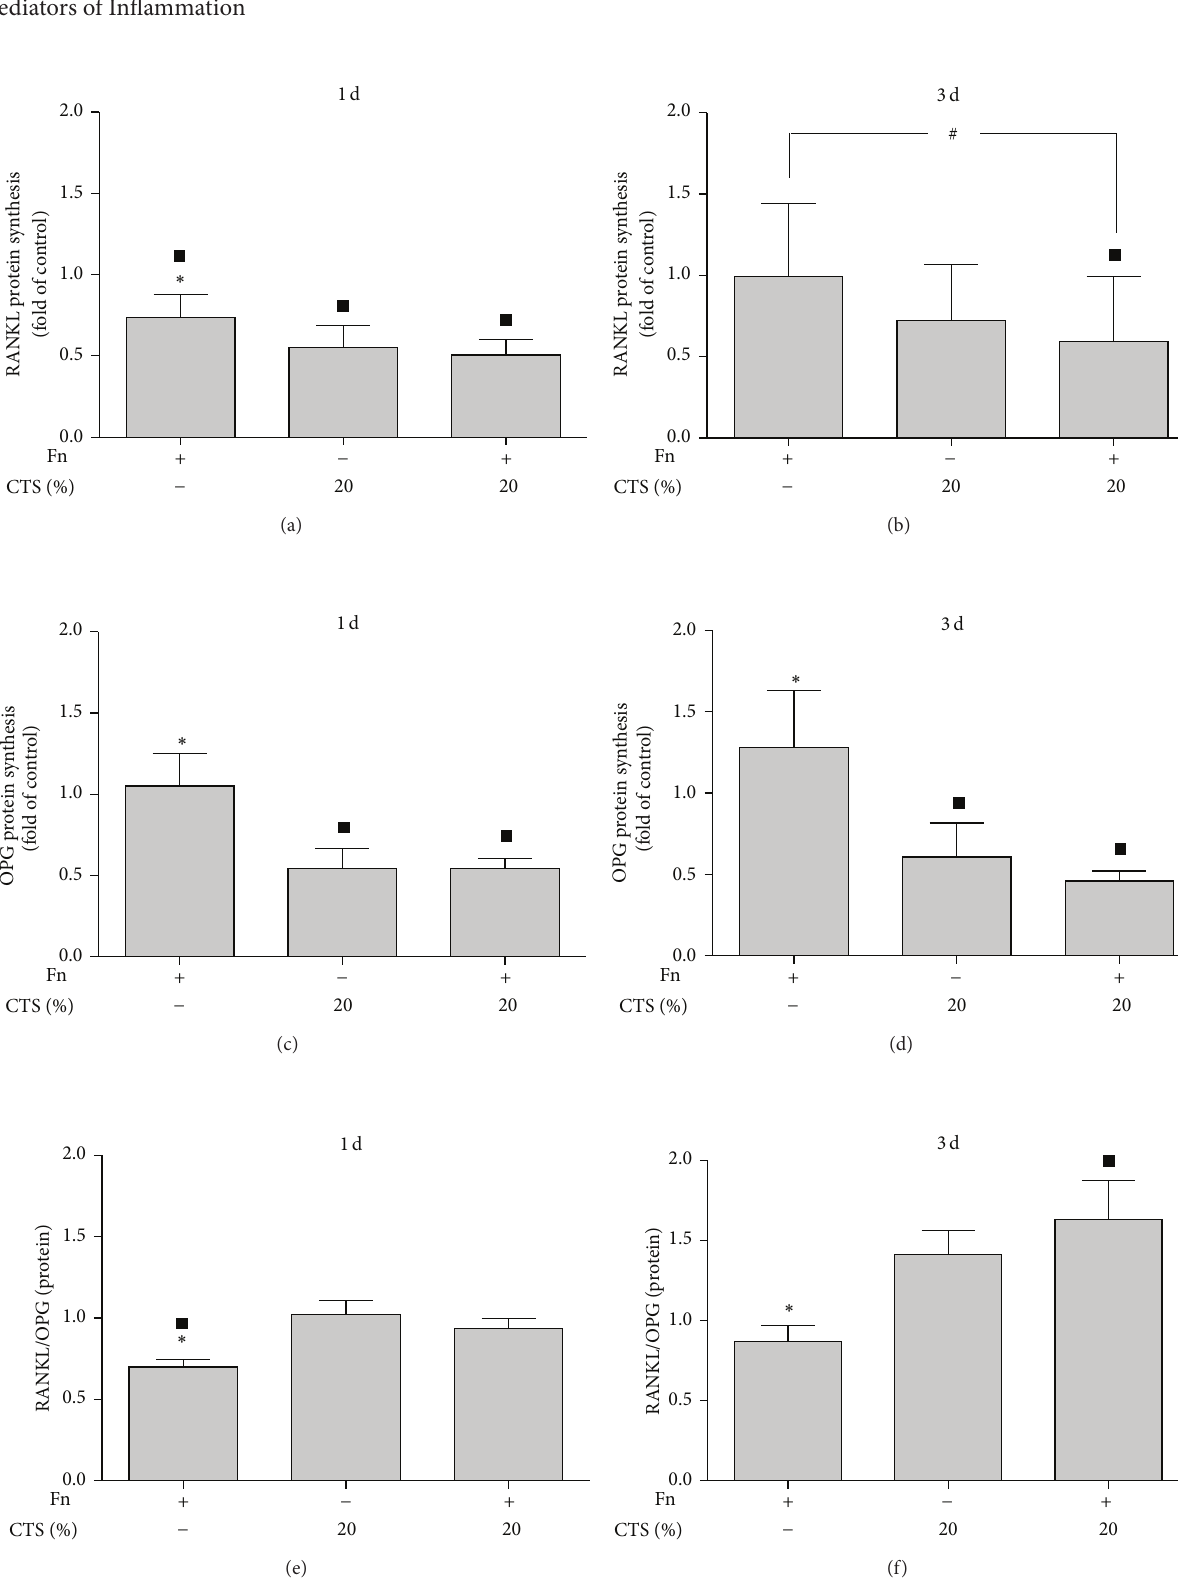
Figure 4: (a and b) Synthesis of RANKL protein in supernatants of PDL cells stimulated by F. nucleatum ATCC 25586 and/or CTSH at 1 day (a) and 3 days (b). (c and d) Synthesis of OPG protein in supernatants of PDL cells stimulated by F. nucleatum ATCC 25586 and/or CTSH at 1 day (c) and 3 days (d). (e and f) RANKL/OPG protein ratio in supernatants of PDL cells stimulated by F. nucleatum ATCC 25586 and/or CTSH at 1 day (e) and 3 days (f). ∗ Significant difference compared to other groups ( 𝑃 < 0.05 ), ◼ significant difference compared to control ( 𝑃 < 0.05 ), and # significant difference ( 𝑃 < 0.05